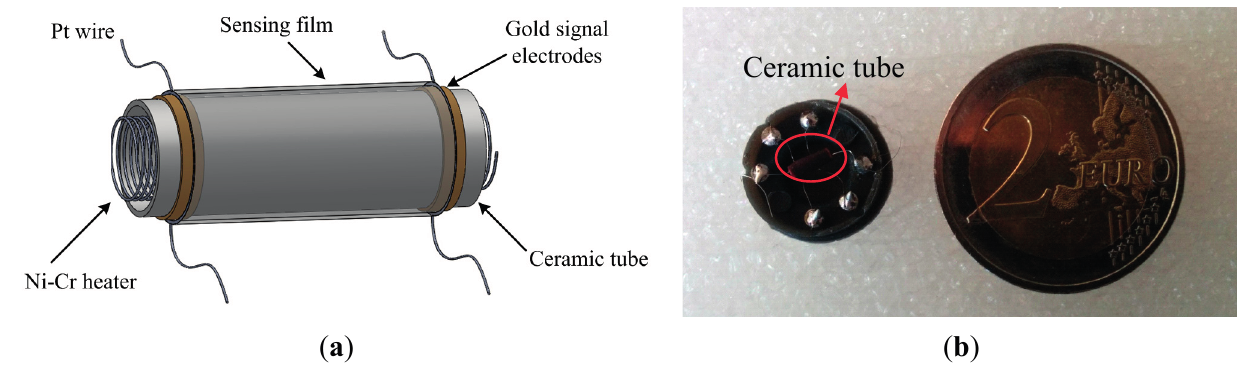
Figure 1. ( a ) Schematic of a gas sensor; ( b ) Illustration of a gas